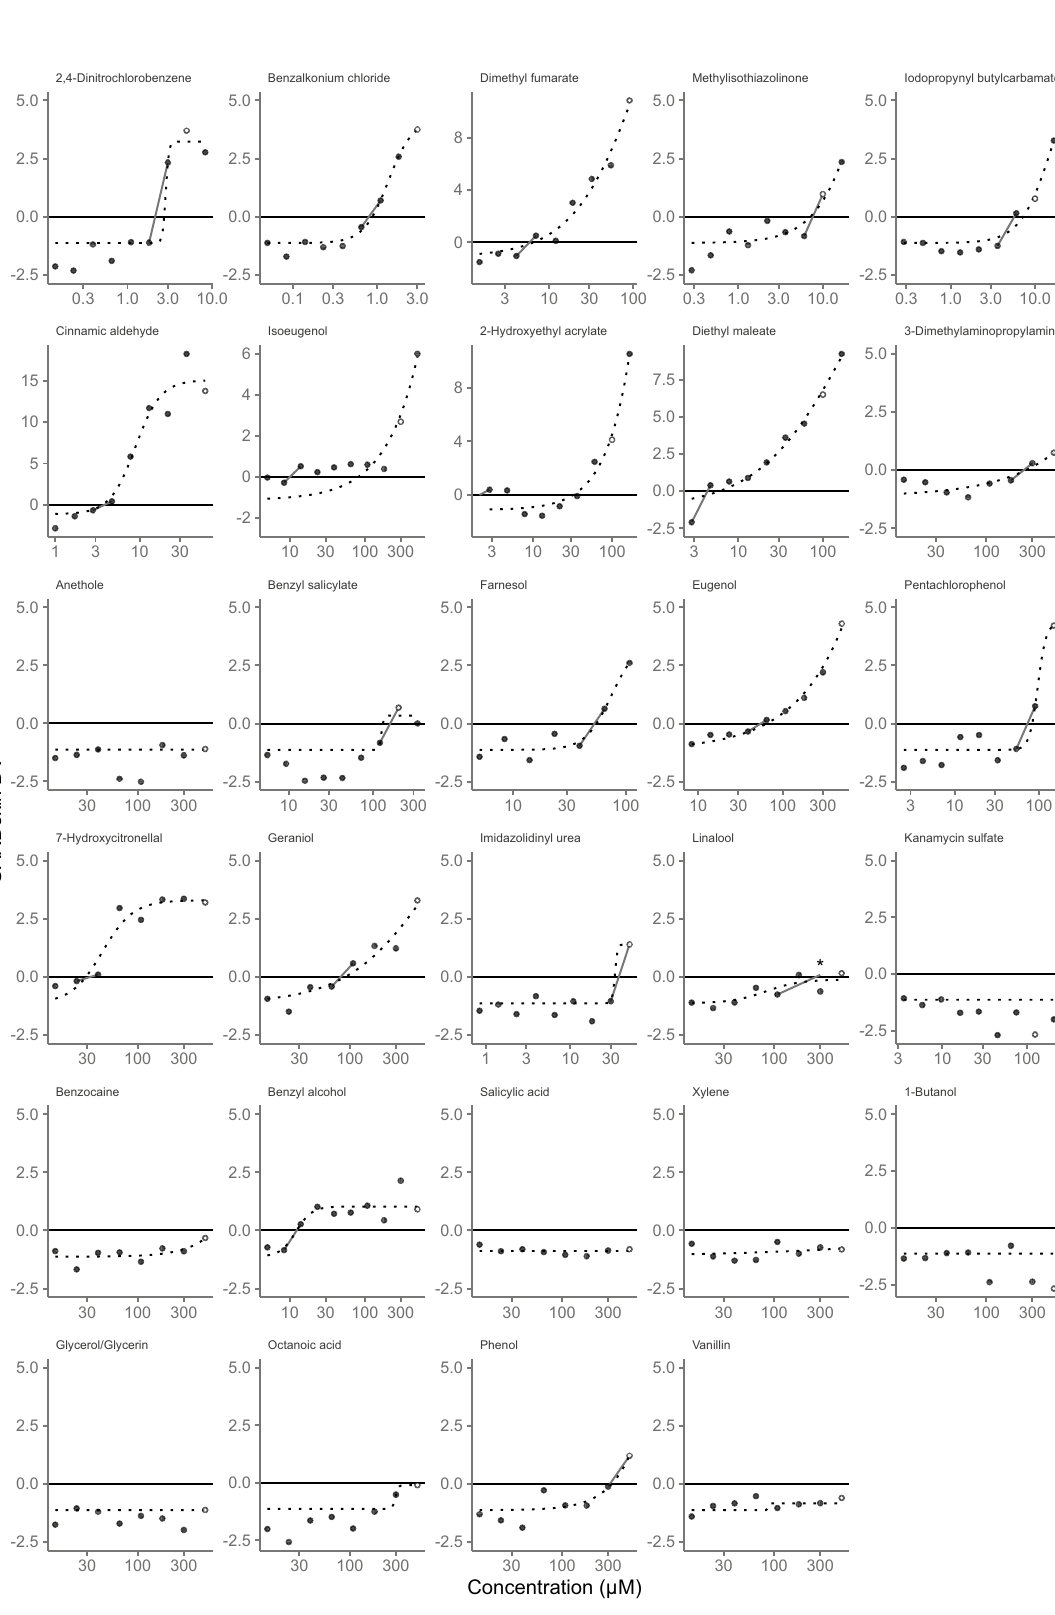
Figure 1. Dose–response relationships for the examined chemicals. Points represent measured response values (decision values) at respective concentrations. Points with white centers represent the GARD input concentrations. Dotted lines describe the log-logistic models, and the solid lines describe the linear interpolations. *The running median was used as positive interpolation point to reduce the potential impact of